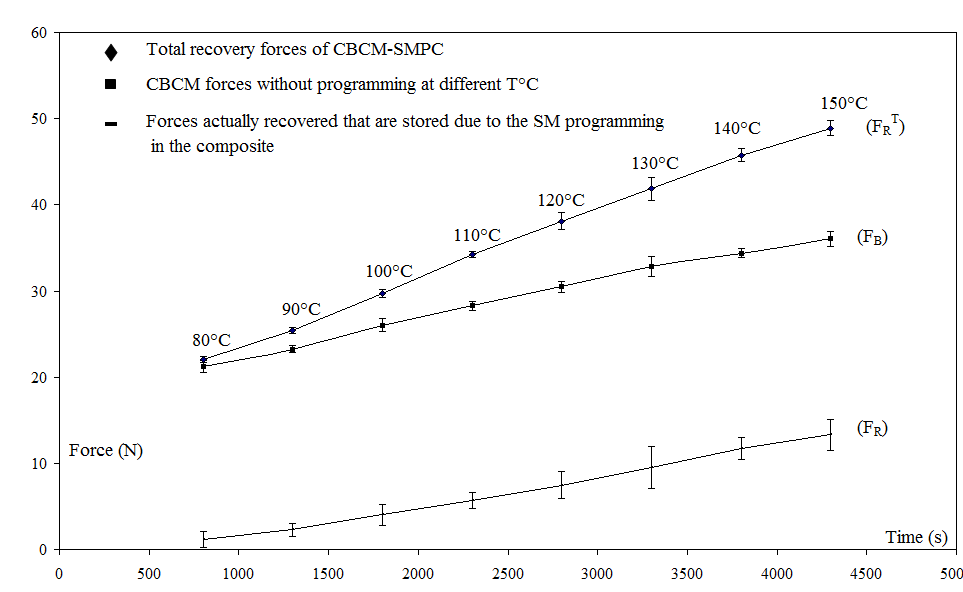
Figure 9. Force evolutions during a constrained multi-step recovery cycle, d I (ε I = 2.12% ± F